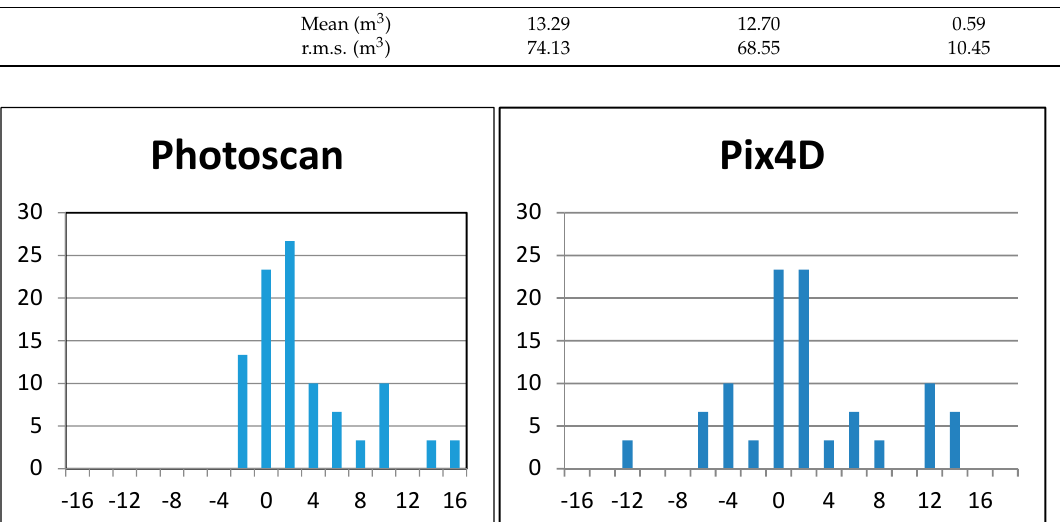
Figure 14. Areas data histogram with frequency (%) in the y-coordinate and the differences in the x-coordinate.